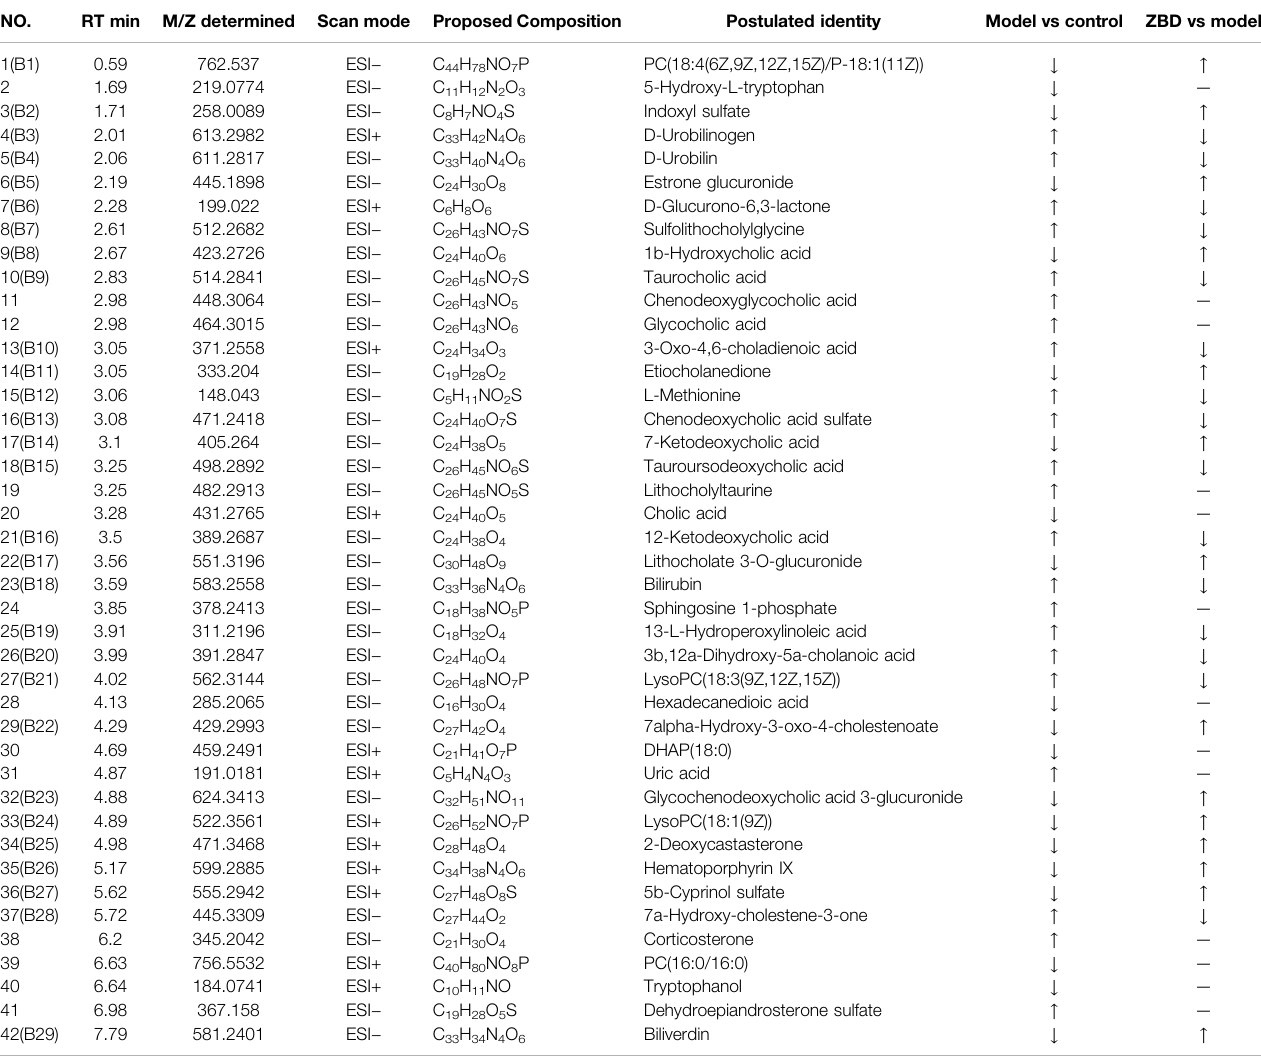
TABLE 1 | Detailed information on biomarkers tentatively identi fi ed by serum metabolomics. NO. RT min M/Z determined Scan mode Proposed